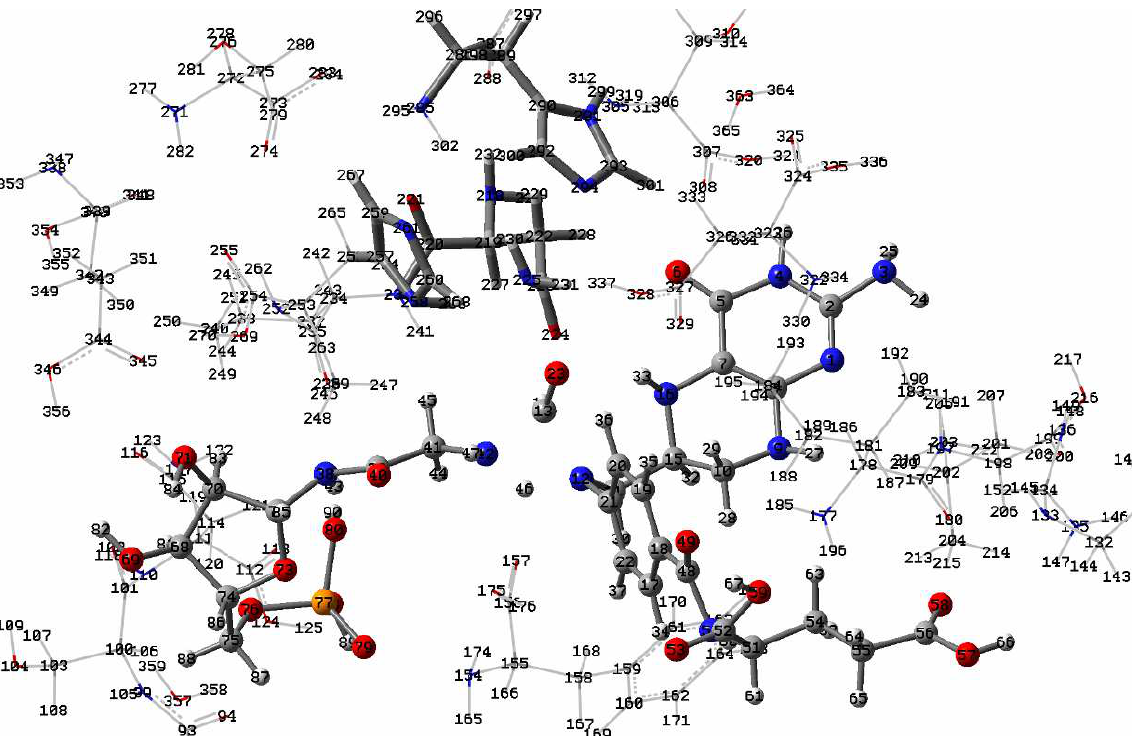
Fig. 3 The three-dimensional structure of TS1